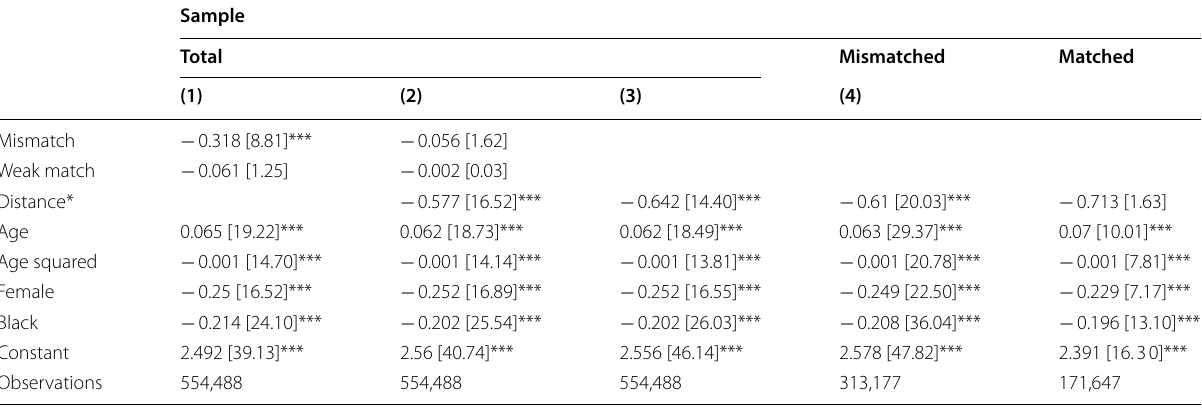
The dependent variable is the logarithm of the hourly labor earnings All regressions include regional dummies and dummies for fields of study Regressions are estimated by OLS and robust t-statistics are in brackets Standard errors are clustered at the occupation-field of study level *, **, ***—indicate significance on the 10%, 5% and 1% level